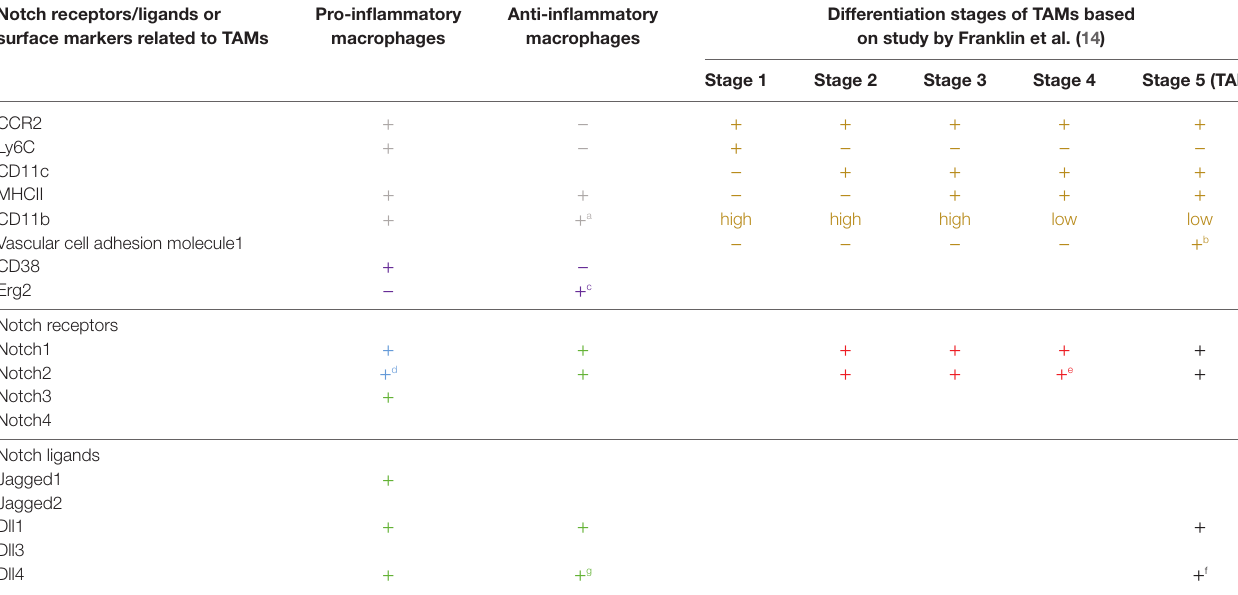
TAble 1 | Expression profiles of Notch ligands and receptors and some stage-specific makers in tumor-associated macrophages (TAMs). Notch receptors/ligands or surface markers related to